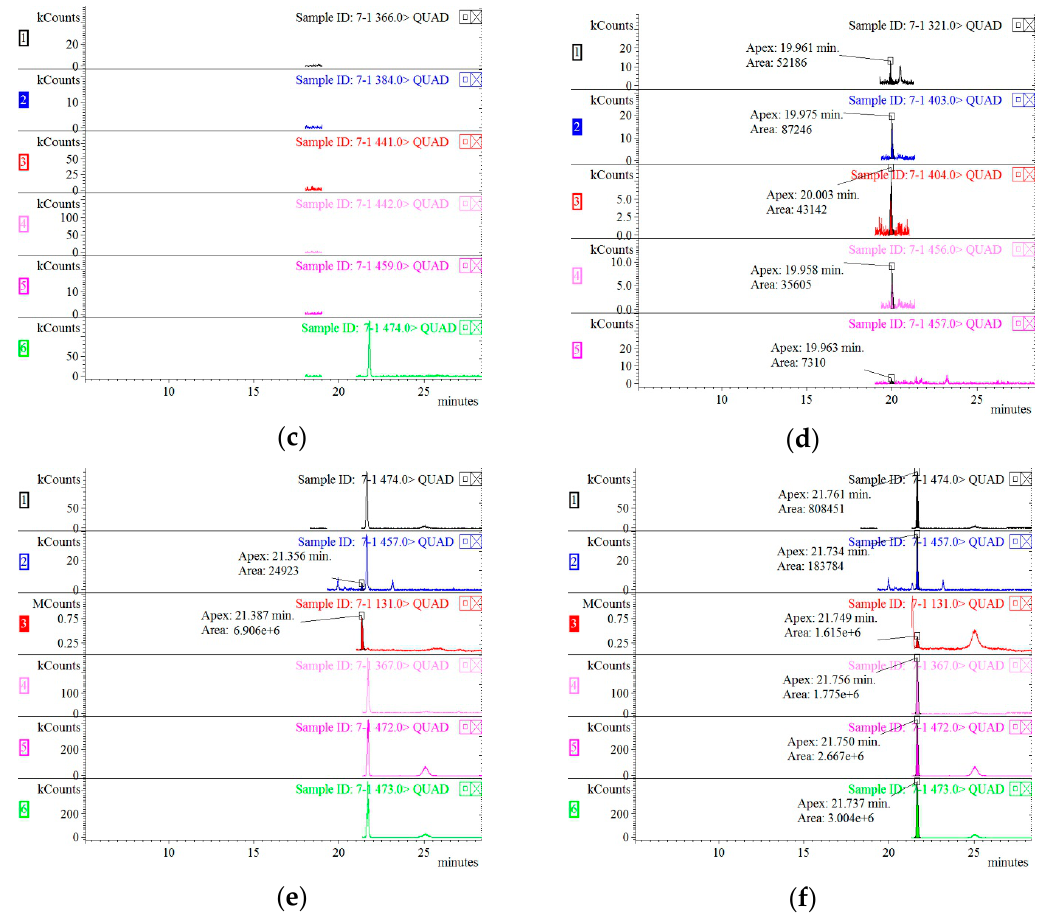
Figure 1. ( a ) Gas chromatography-mass spectrometry (GC-MS) chromatogram of five cholesterol oxidation products (COPs) standards detected by full-scan mode. Peaks: 1, 7 β -OH; 2, 5,6 α -EP; 3, triol; 4, 25-OH; and 5, 7-keto. ( b – f ) GC-MS chromatograms of five COPs in a hock skin after 8 th cycle detected by selected ion monitoring mode. b, 7 β -OH; c, 5,6 α -EP; d, triol; e, 25-OH; and f, 7-keto.